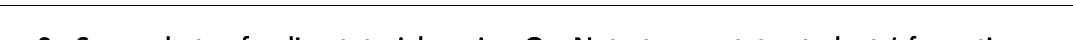
Figure 2. Screenshots of online tutorials, using OneNote to annotate students’ formative work during the session (Source: Author,